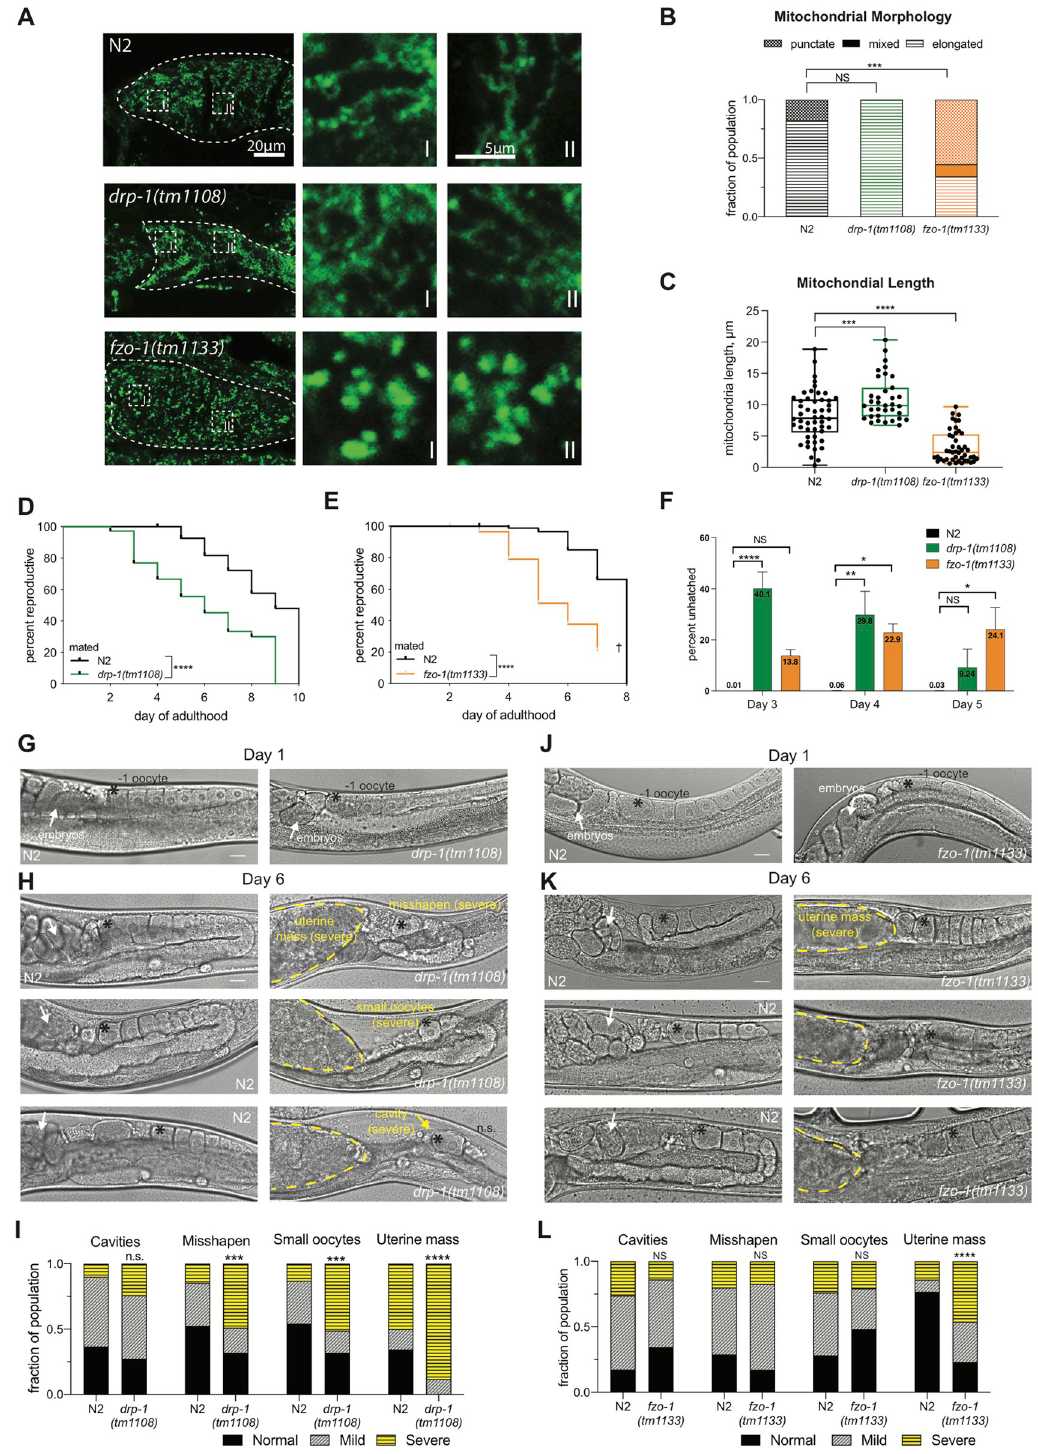
Fig 2. Fission and fusion are necessary for normal reproductive function with age. (A) Mitochondrial morphology in mature oocytes of N2, drp-1(tm1108) , and fzo-1(tm1133) in Day 3 adults. Representative images highlight the different morphologies in N2 (elongated), drp-1(tm1108) (elongated), and fzo-1(tm1133) (punctate). White-dotted boxes are enlarged (right) of the morphology in the -1 oocyte (I) and the -2 oocyte (II). Images in A were processed using the same parameters across the entire image (i.e. adjusting for brightness and contrast). (B) Blind scoring results of mitochondrial morphology in the -1 oocyte in